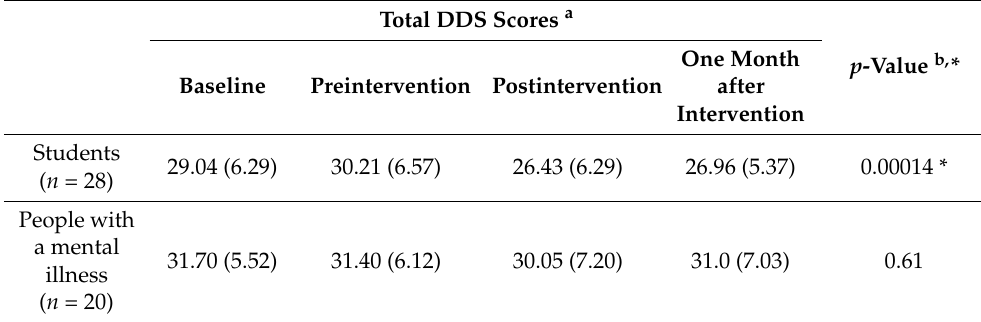
Table 2. Total DDS scores of students and people with mental illnesses across four time